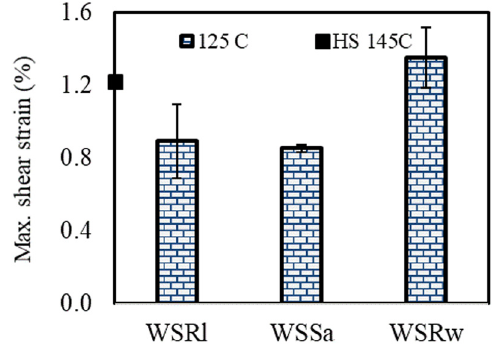
Figure 20: Final maximum shear strain at the termination of MSCR.